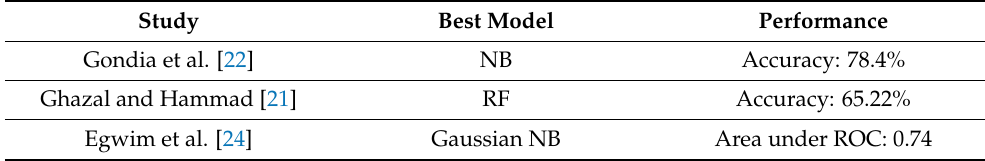
Table 9. Compared